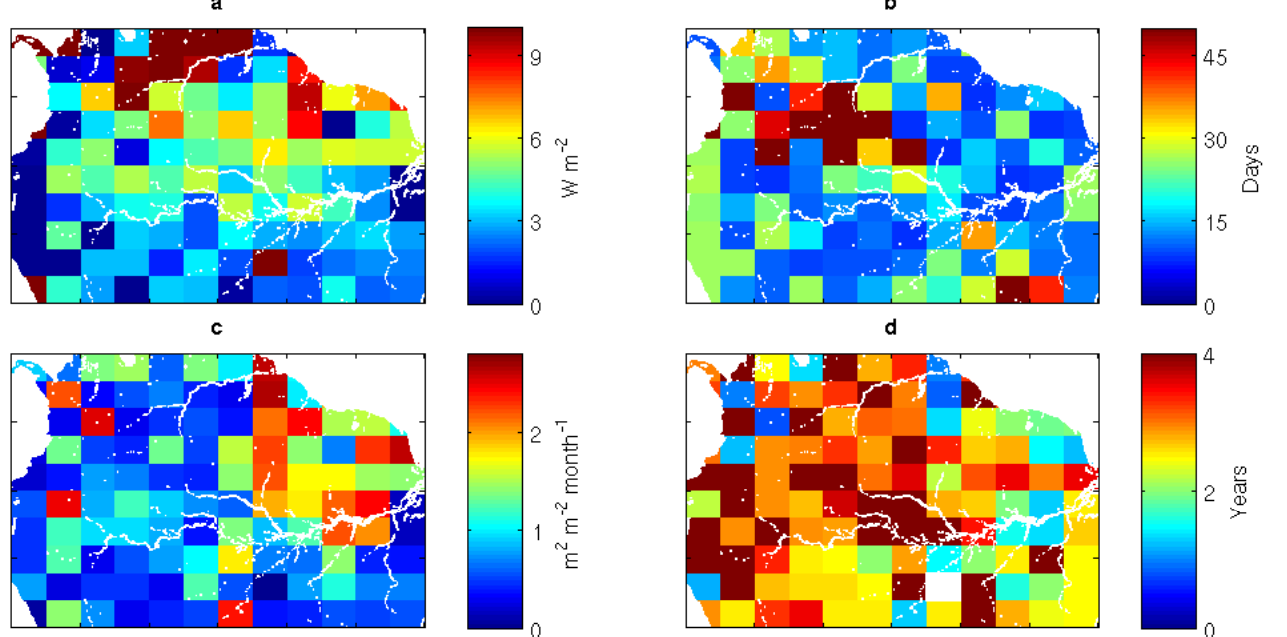
Fig. 6. Mean posterior parameters that describe leaf gain and loss: (a) direct PAR compensation point, C direct (Wm − 2 ); (b) delay in vege- tation response to changes in PAR, p (days); (c) maximum number of leaves that can be added over a month, gain max (m 2 m − 2 month − 1 ); and (d) mean cohort leaf lifetime τ 95 defined as the time at which 95% of the leaves from a cohort have dropped